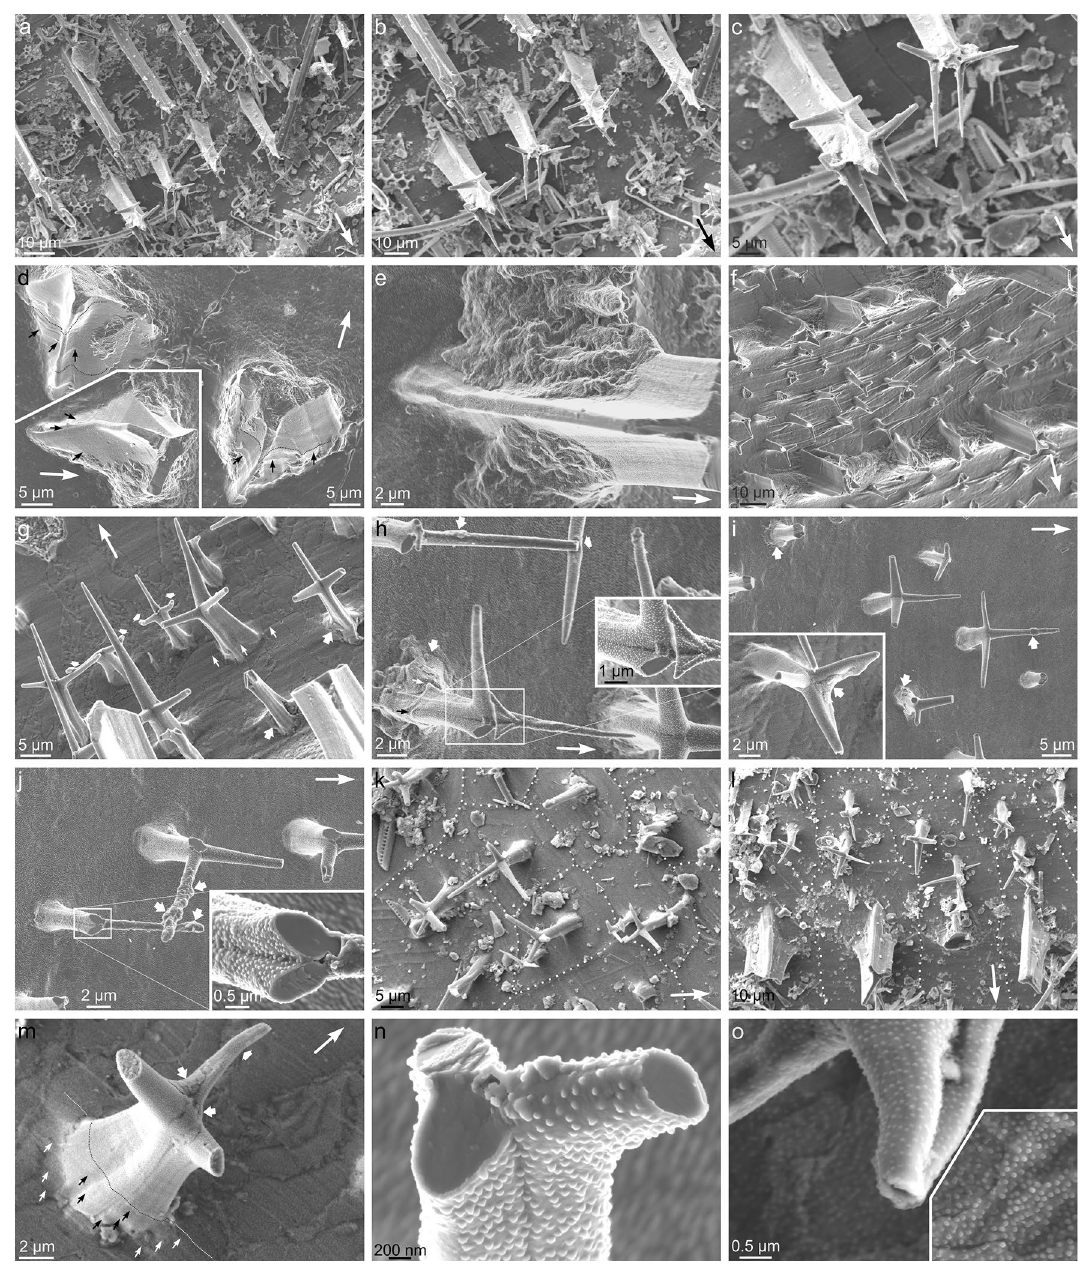
Figure 3. External morphology and distribution of first- and second-order aerials of Catillopecten natalyae. ( a )–( c ) Extremely well preserved first-order aerials showing the arrangement of evenly distributed spikes at 120° (in top view), following three-fold symmetry. ( d ) Distribution of growth lines (small arrows) close to the base of broken first-order aerials. Some growth lines have been outlined with broken lines. Note irregular additional deposits at the sides of the aerials. ( e ) Detail of the base of a first-order aerial surrounded by secondary deposits. Growth lines are also visible on the aerial. ( f ) General view of two ribs and the inter-rib space, together with the accompanying first- and second- order aerials, respectively. There are abundant periostracal wrinkles. ( g ) Oblique view of second-order aerials. Some of them show secondary deposits at their bases (intermediate arrows). The short wide arrows indicate bent branches, and the thin arrows point to growth lines. ( h ) Details of second-order aerials showing consistent smooth fractures at high angles to the branch axes (inset). Note duplicate branches in the framed aerial. Arrows indicate as in g . ( i ), ( j ) Set of second-order aerials showing secondary deposits both at their bases and branches (intermediate arrows). Note smooth fractures at consistent angles to the branches in j (inset). ( k ), ( l ) Top views of groups of aerials. Note strict co-orientation of branches when aerials settle on the same prism (prism outlines indicated with loosely dotted lines). The short wide arrow in l indicates a bent branch. ( m ) Aerial with well-defined secondary deposits (thick arrows) and growth lines (thin arrows, and broken line). The short wide arrow points to a bent branch. The shell surface displays outlines of irregular elongated grains. ( n ) Detail of an aerial showing smooth fractures at consistent inclinations and orientations with respect to the branch axes. ( o ) Details of the tip of a branch and the underlying shell surface (inset). Note marked difference in the density of periostracal pimples. The long arrows in ( a ) to ( m ) indicate the growth direction of the